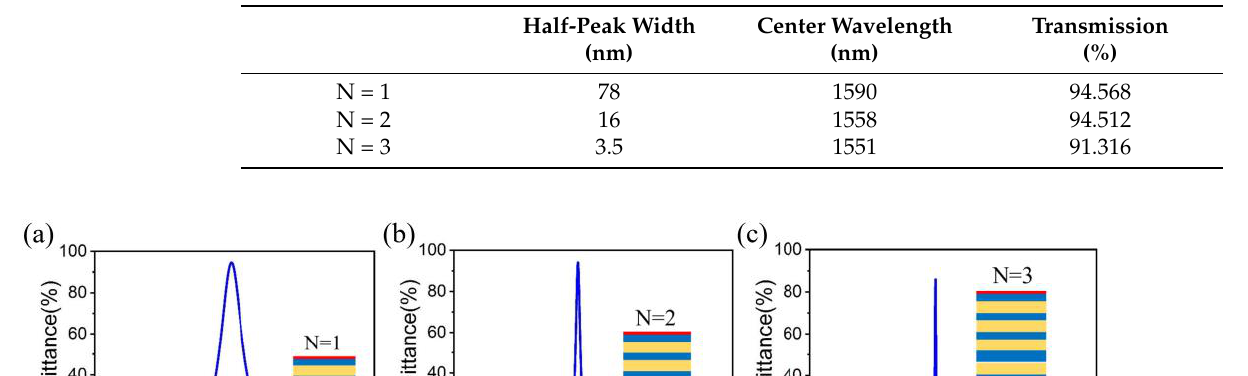
Table 2. The influence period on parameter.